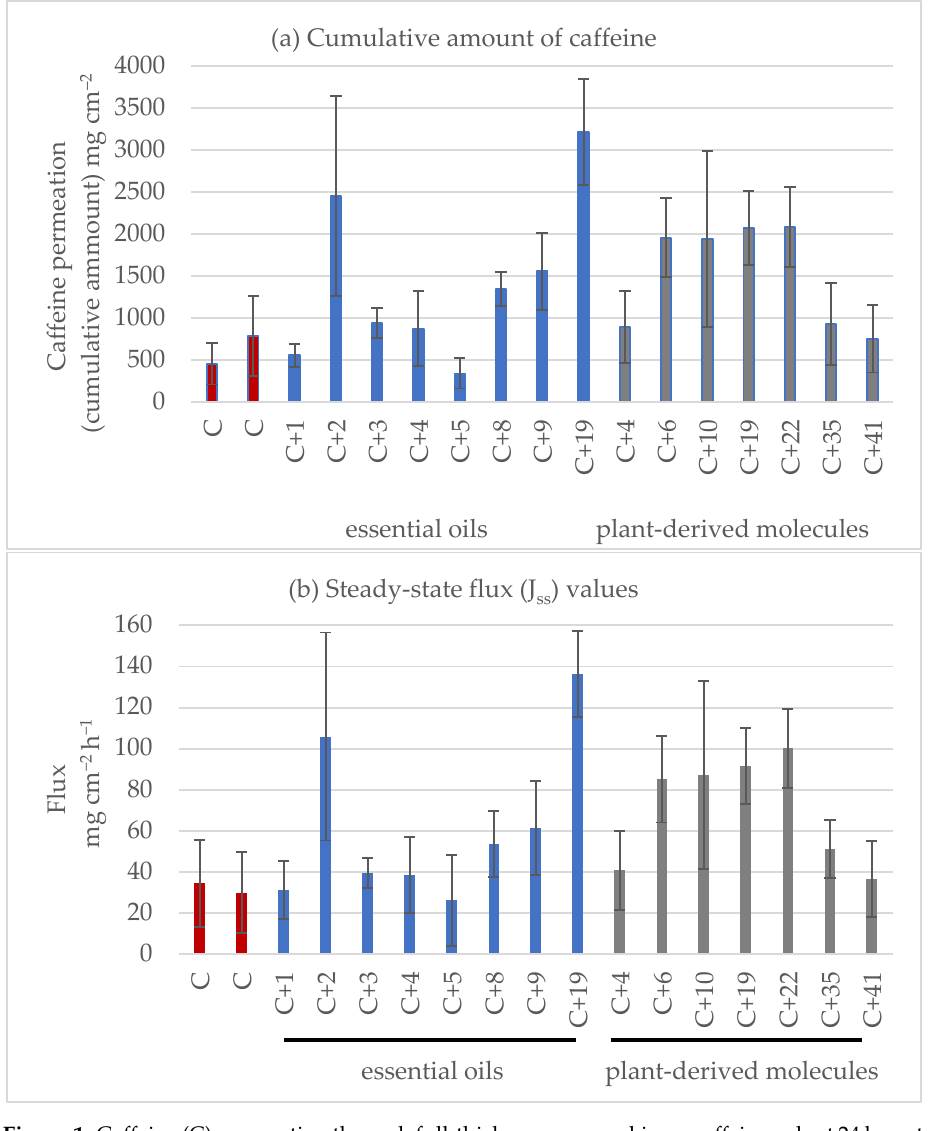
Figure 1. Caffeine (C) permeation through full-thickness mouse skin on caffeine gels at 24 h containing different essential oils (EOs) and plant-derived metabolites (PDMs). ( a ) The cumulative amount of caffeine and ( b ) steady-state flux (J ss ) values. The results obtained with the 1% w / w caffeine gel formulation (control without permeant) are shown in red bars; formulations of 1% w / w caffeine plus 1% w / w EO 1,2,3,4,5,8,9, and 19 are shown in blue bars; formulations of 1% w / w caffeine gel plus plant-derived metabolites 4, 6, 10, 19, 22, 35, and 41 are shown in grey bars. Data are shown as the means ± SEMs, n = 6 .